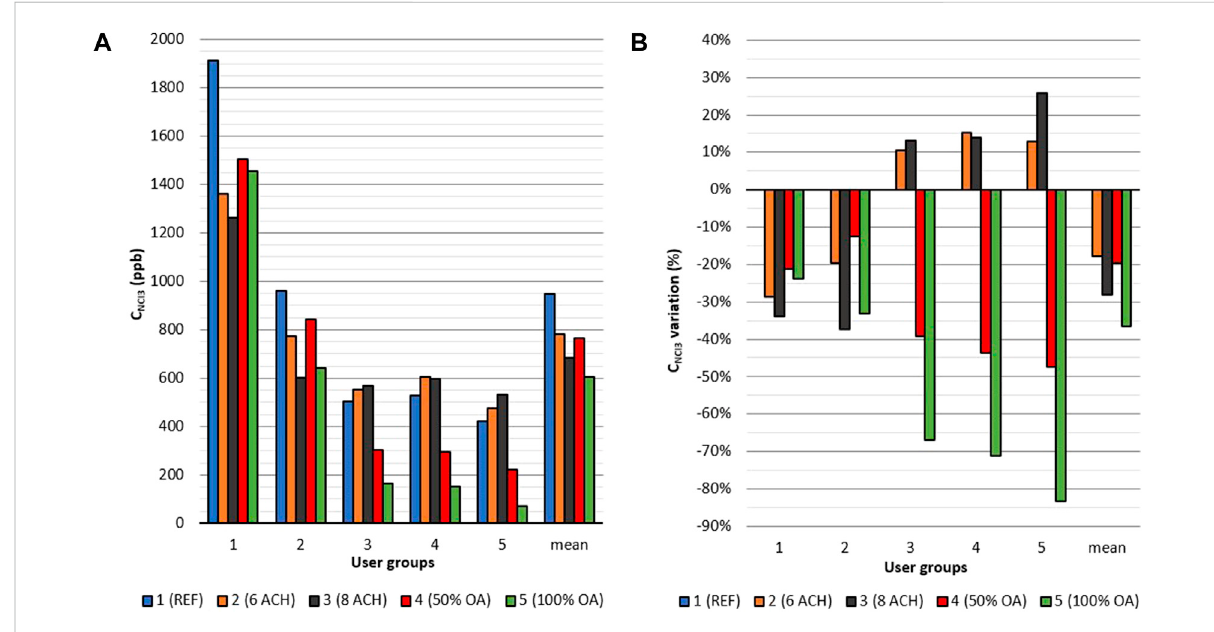
FIGURE 8 C NCl3 for the fi ve user groups: (A) absolute values and (B) variation with the reference case (sim. 1).